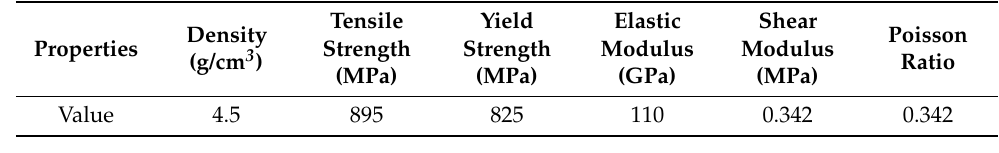
Figure 6. Experimental platform for cutting forces coefficients in TriMule based helical milling.